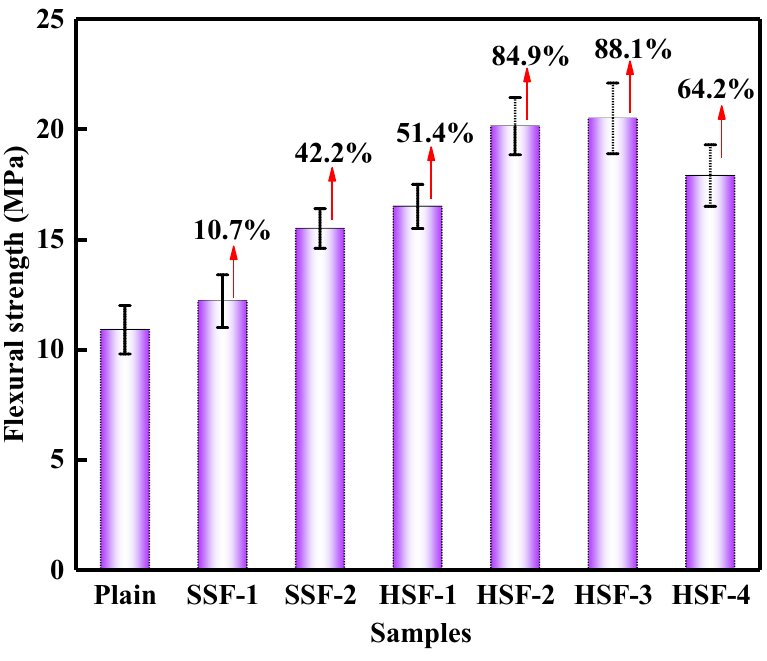
Figure 3. Flexural strength of FRC.